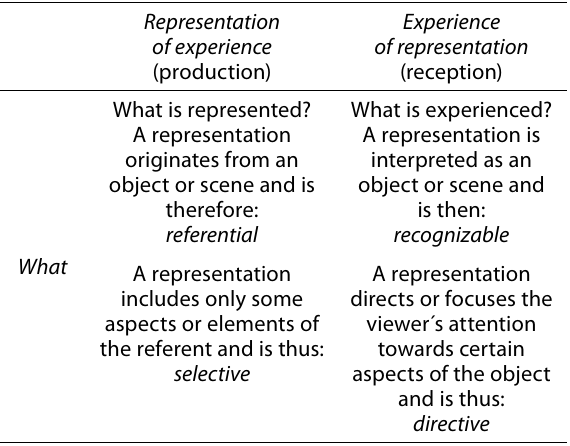
Table 2. The sine qua non qualities or conditions of representation in relation to the content or the what of representation.